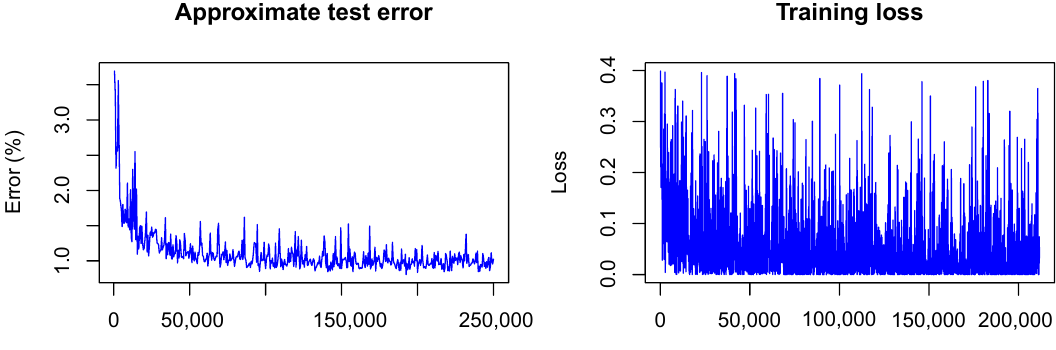
Figure 6. Visualization of the network training without dropout.